Question: Identify the chart type used in this figure.
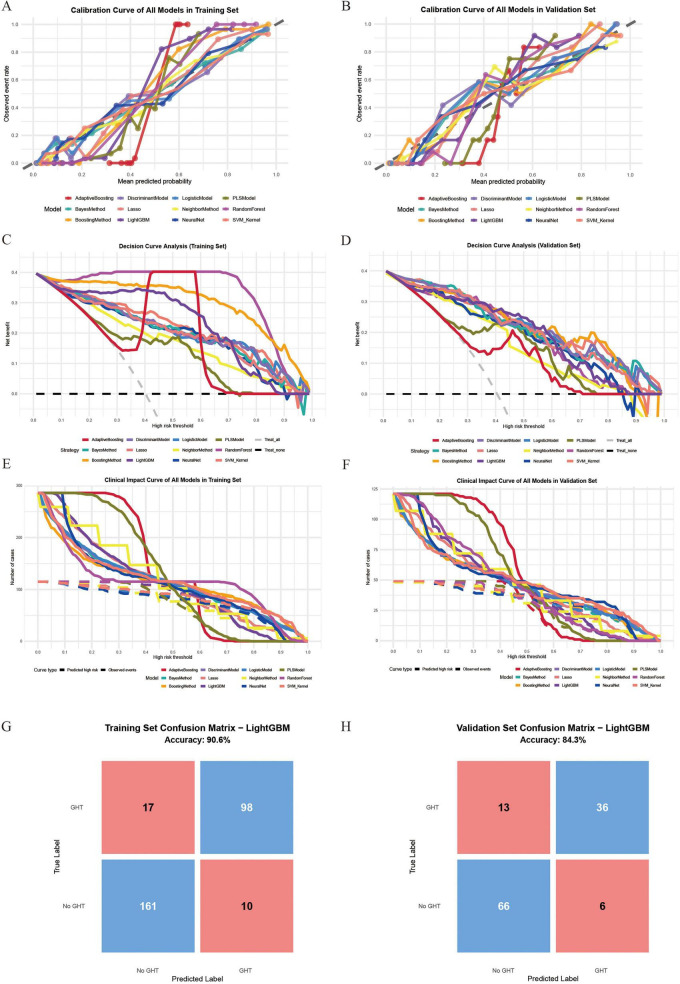
Answer: heatmap